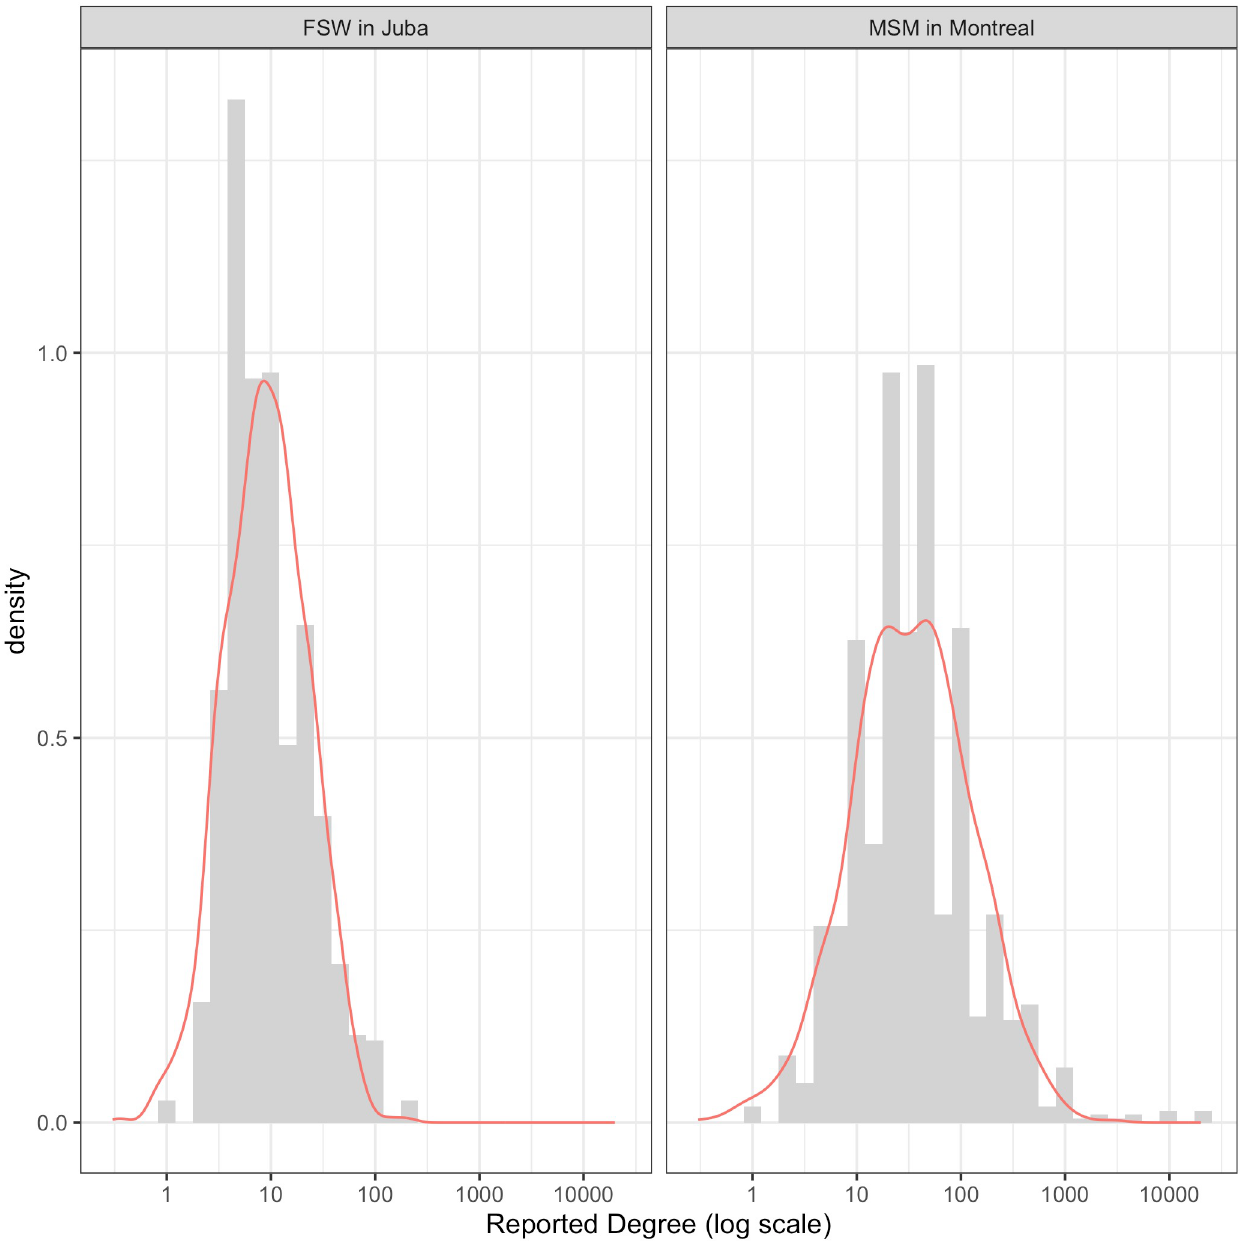
Fig 2. Example distribution densities. Distribution of reported network degree for MSM from Montreal, Canada (n = 1179) and FSW from Juba, South Sudan (n = 846). Both samples are best described by the normal distribution on log-transformed degree.